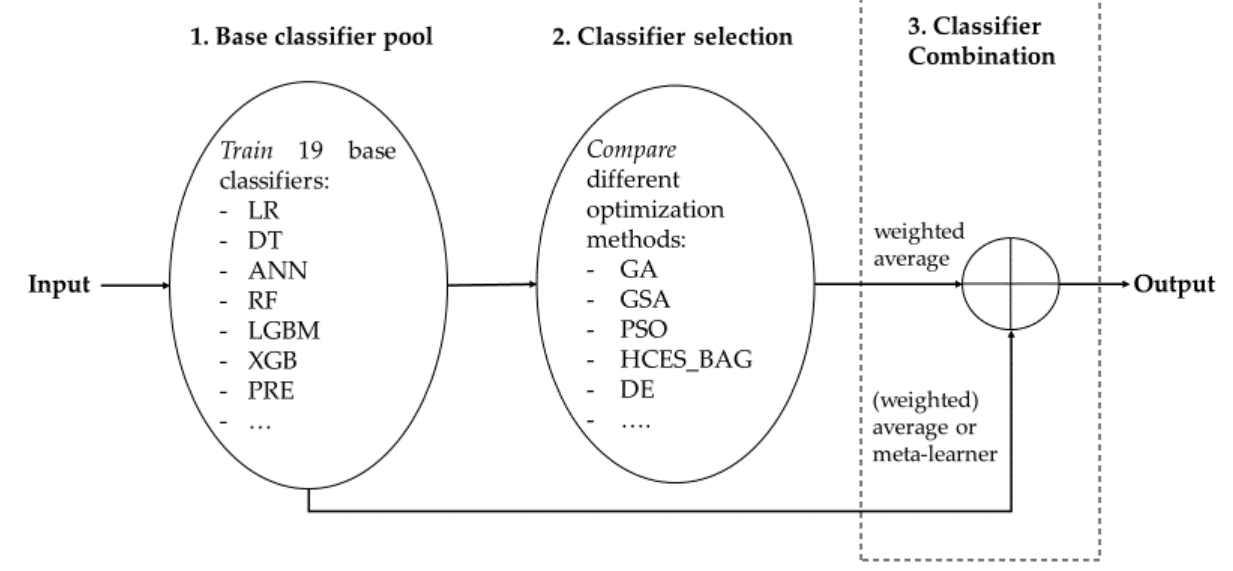
Figure 1. Graphical depiction of the main principles of our proposed heterogeneous ensemble framework. Table 4. Overview of our heterogeneous ensembles.